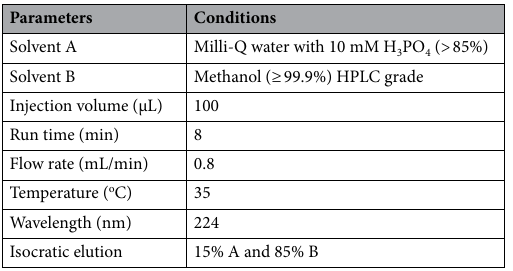
Table 1. UHPLC operating conditions.